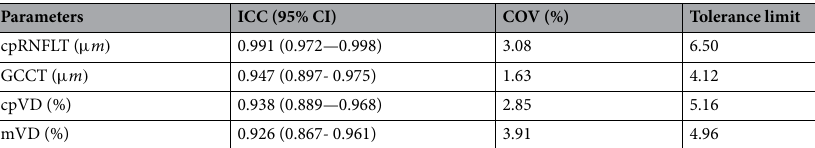
Table 3. Longitudinal variability measurement determined by OCT/OCTA-derived parameters in 33 healthy eyes. CI confidence value, COV coefficient of variation, cpRNFLT circumpapillary retinal nerve fiber